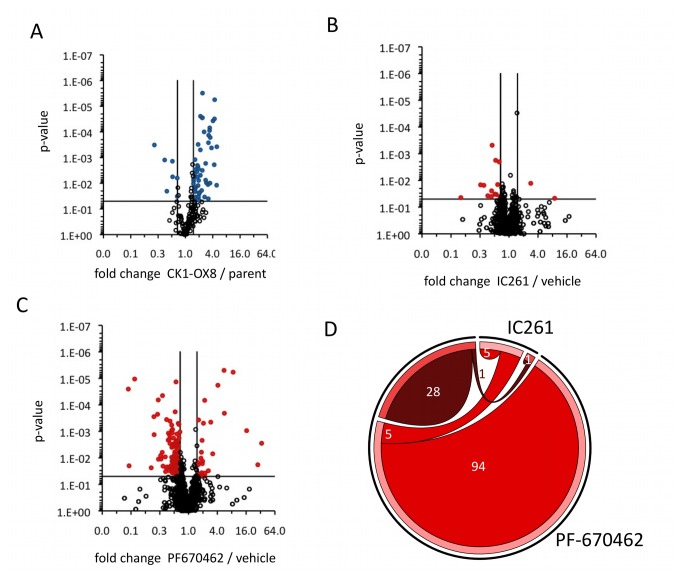
Changes to the phospho-proteome upon CK1 modulation.(A) Volcano plot visualising quantified phospho-sites with significant differences between CK1-OX8 and CCA1-LUC in a pair-wise comparison, using label-free quantification by mass spectrometry. Criteria were p<0.05 and fold changes >1.5 or <0.67, as indicated by black lines. Blue data-points represent significantly differential phospho-sites, black circles represent those that do not change significantly. The identities of these sites can be found in Supplementary Dataset S1. (B–C) Volcano plots visualising quantified phospho-sites with significant differences between mock-treated cells and cells inhibited for CK1 using IC-261 (B) or PF-670462 (C) in pair-wise comparisons, using label-free quantification by mass spectrometry. Criteria were p<0.05 and fold changes >1.5 or <0.67, as indicated by black lines. Red data-points represent significantly differential phospho-sites, black circles represent those that do not change significantly. The identities of these sites can be found in Supplementary Dataset S2 (D) Chord diagram showing the numbers of identified phospho-sites whose abundance significantly differs upon drug treatment with either IC261 or PF-670462 from their respective controls (>1.5-fold change, p<0.05, n=5), and the overlap between the indicated data sets. Up-regulated peptides are represented in dark red, down-regulated peptides in lighter red.